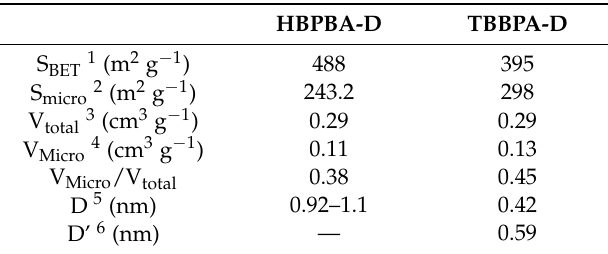
Figure 3. N 2 sorption isotherms of ( a ) HBPBA-D and TBBPA-D at 77 K/1 bar; ( b ) PSD profile calculated by NLDFT; ( c ) CO 2 sorption isotherms of TBBPA-D at 273 K; ( d ) PSD of TBBPA-D calculated using the H-K method. Table 1. Porous properties of HBPBA-D and